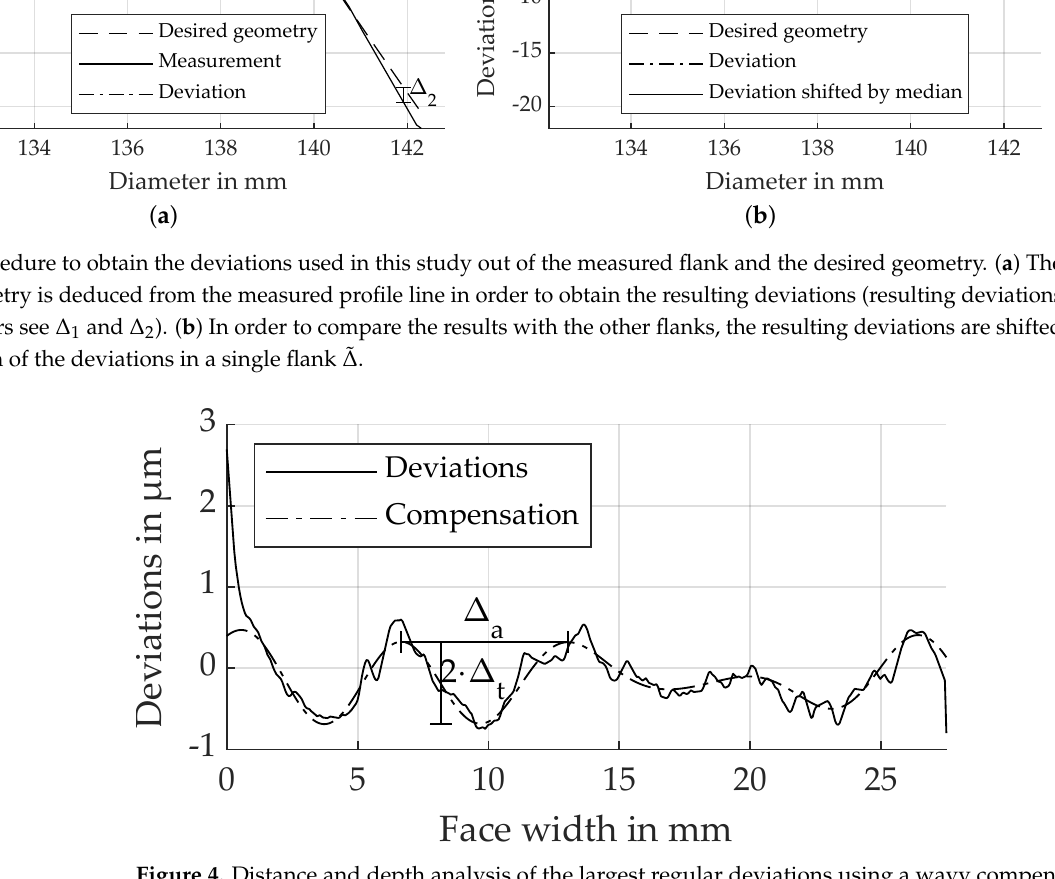
Figure 4. Distance and depth analysis of the largest regular deviations using a wavy compensation curve (the diagram shows DskiPiLZ at tooth nr.